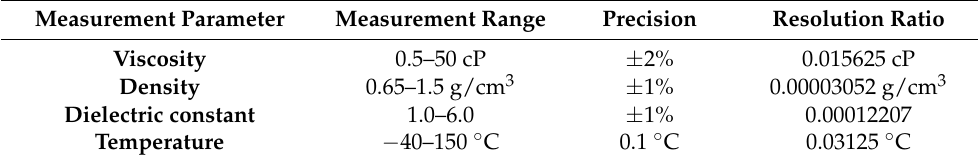
Table 1. Measurement parameters of the sensor.